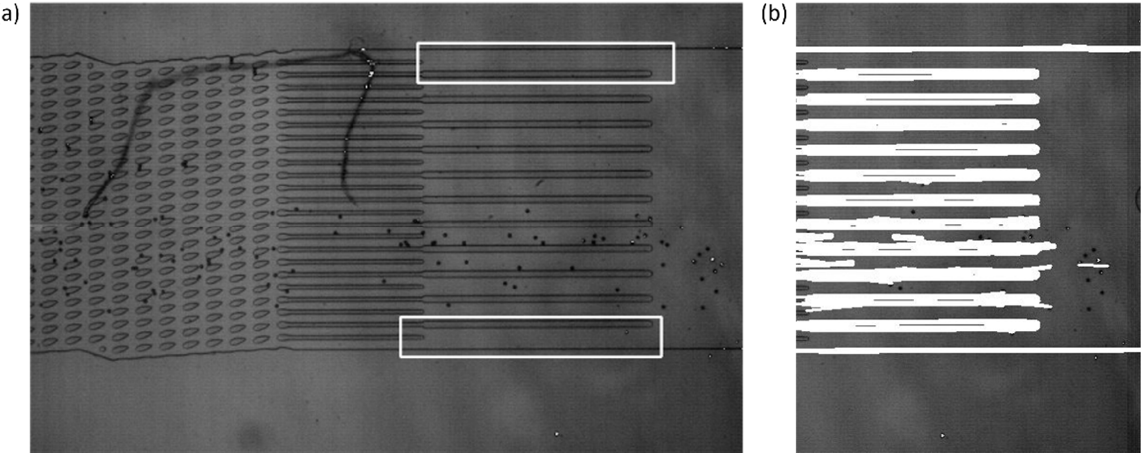
Figure 3. ( a ) The results of the template matching process on the original video frame. The location of the top and bottom templates is indicated by the white outline. The top and bottom templates’ most likely location is given by the minMaxLoc function when it is run on the output of the matchTemplate function. The left and right bounds of the observation window are calculated by averaging the results of the template matching. ( b ) Hough transform results where the white represents lines that were detected by the function. The row values that are the upper-most and lowest of the lines detected are used for the upper and lower bounds of the observation window, respectively.